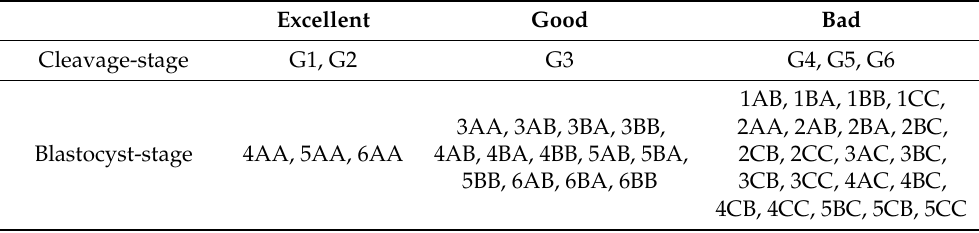
Table 1. The definition of a good-quality embryo (GQE).